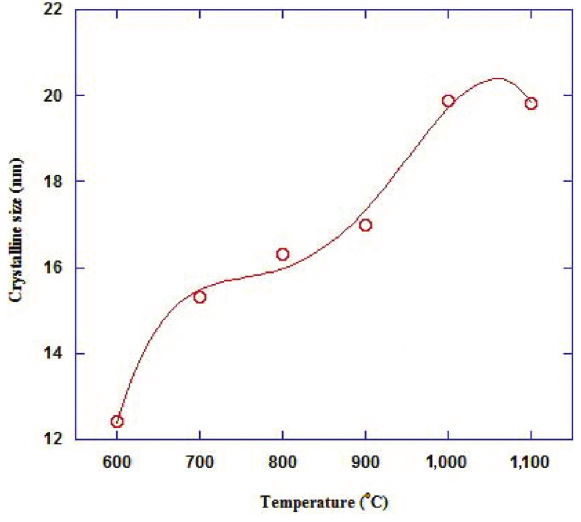
Figure 4: The crystalline size as a function of annealing